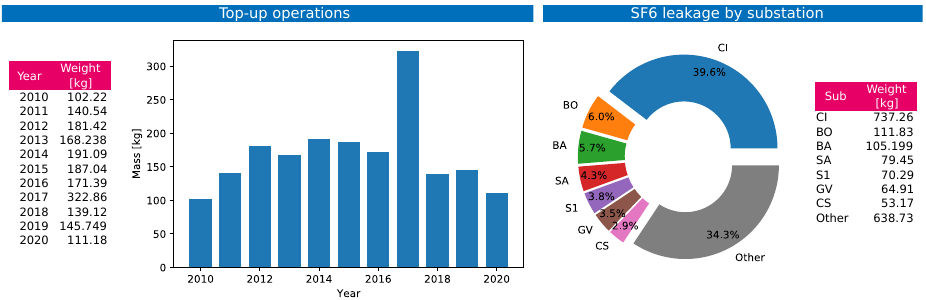
Figure 4. Historical analysis of SF 6 top-ups in ENEL-CODENSA